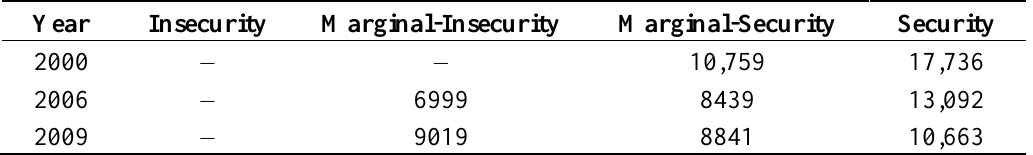
Table 11. Unit comprehensive index of land ecological security in